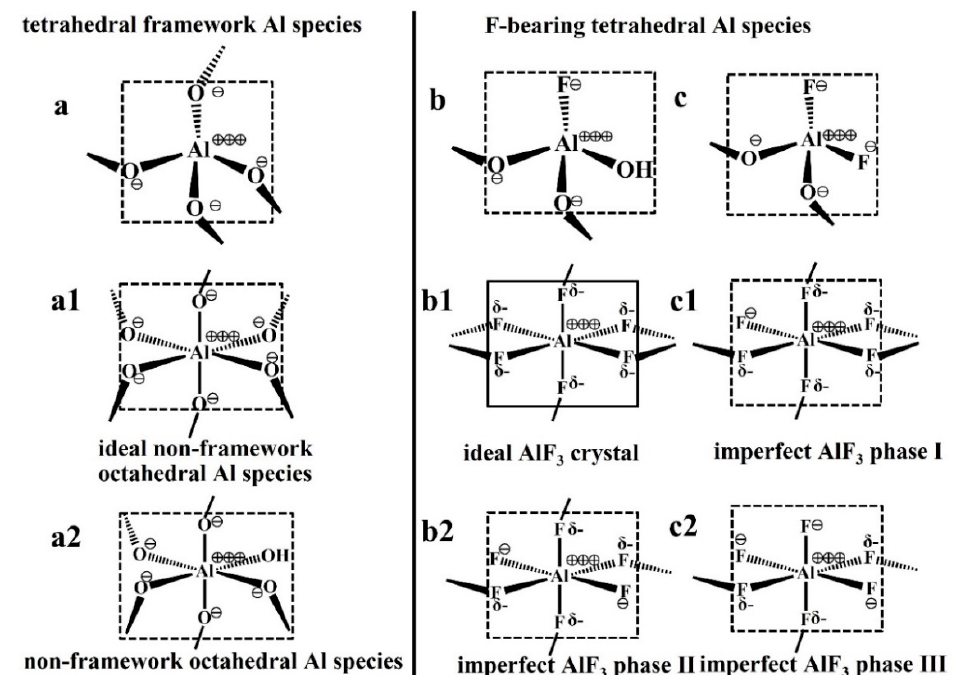
Scheme 1. The Schematic depiction of the comparison among the non-framework Al species ( a ) and